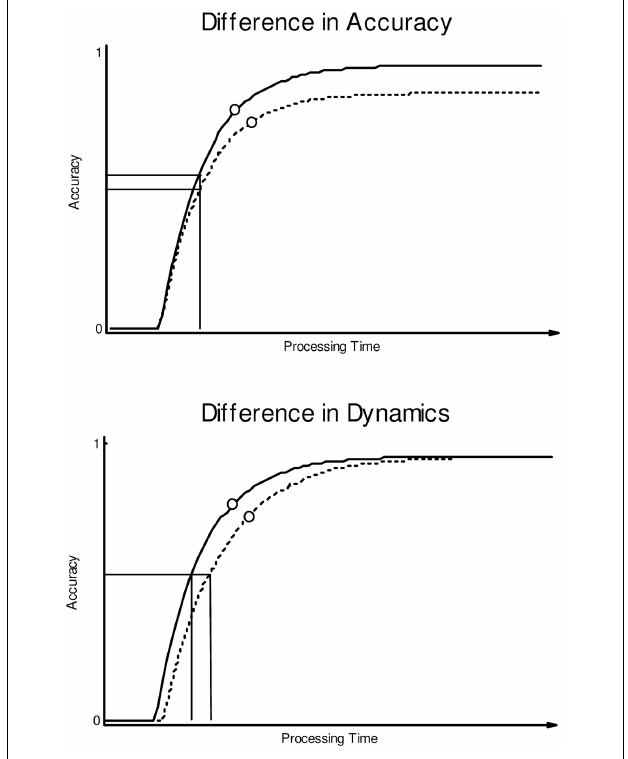
FIGURE 1 | Accuracy (y-axis) as a function of time (x-axis) for two hypothetical conditions (solid vs. dotted curves). The top panel illustrates a cross-condition difference in accuracy, the bottom panel shows a difference in processing dynamics. Horizontal and vertical lines map the 50% asymptotic accuracy level per condition onto corresponding temporal coordinates. The open circles on the curves indicate hypothetical average responses (in time × accuracy space) from a classical RT experiment (see text for further